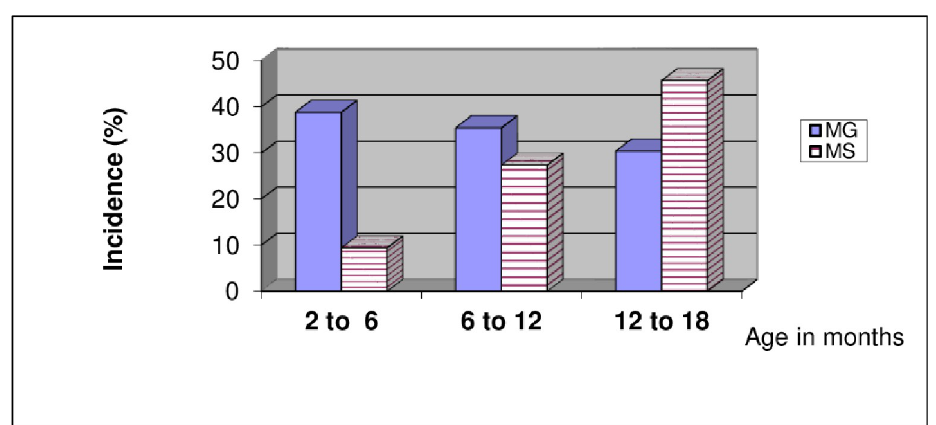
Fig 3. Age-related incidence of mycoplasmosis in native chickens by slide plate agglutination test.